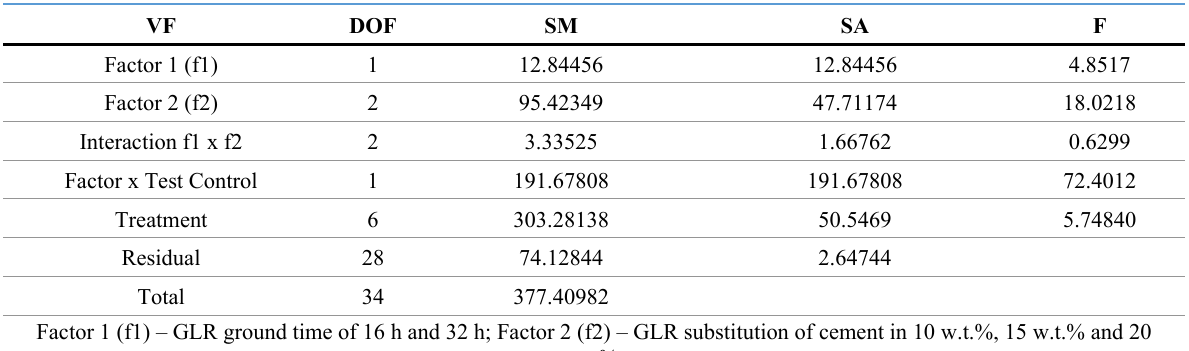
Table 6. Factor analysis of compression strength at 7